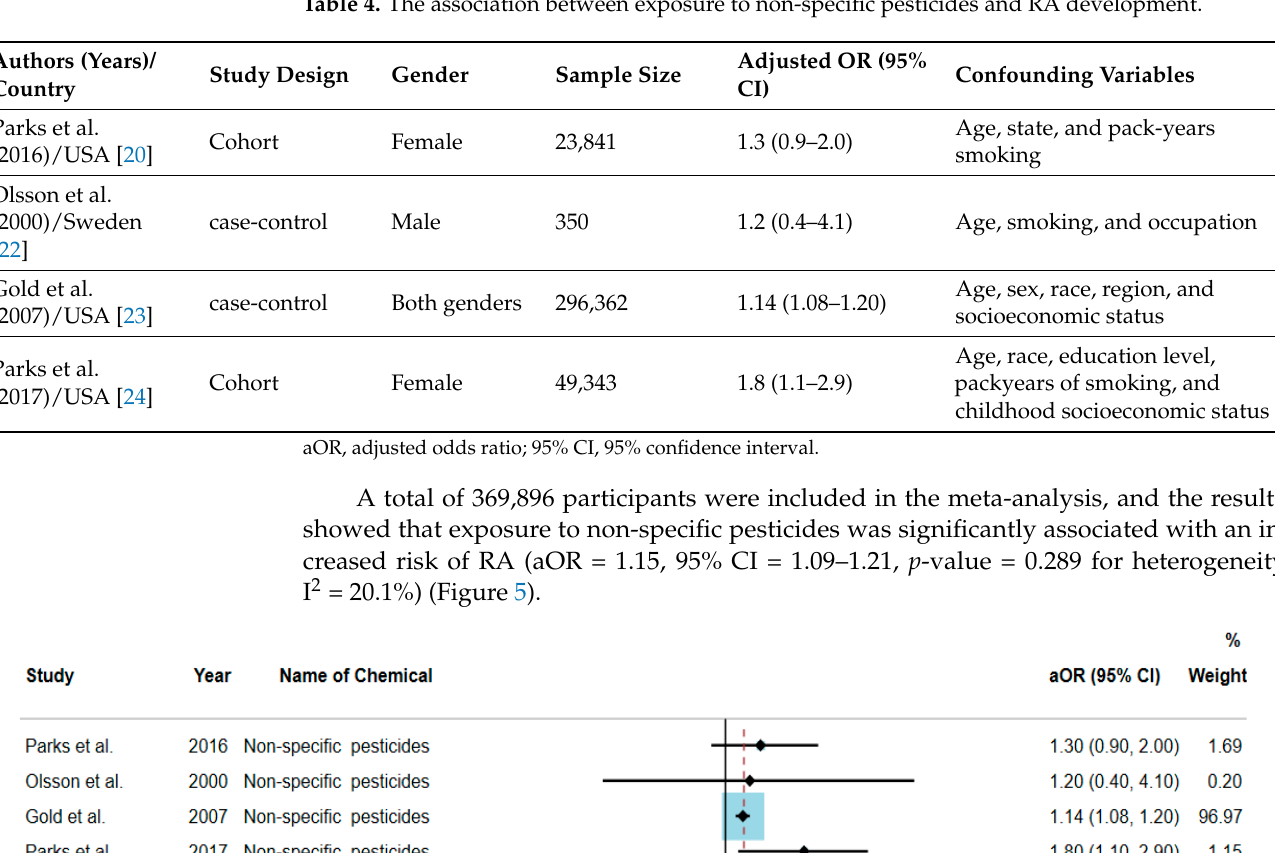
Figure 4. The association between exposure to fungicides and RA development [6,17,20,21]. aOR, adjusted odds ratio; 95% CI, 95% confidence interval. Table 4. The association between exposure to non-specific pesticides and RA development.